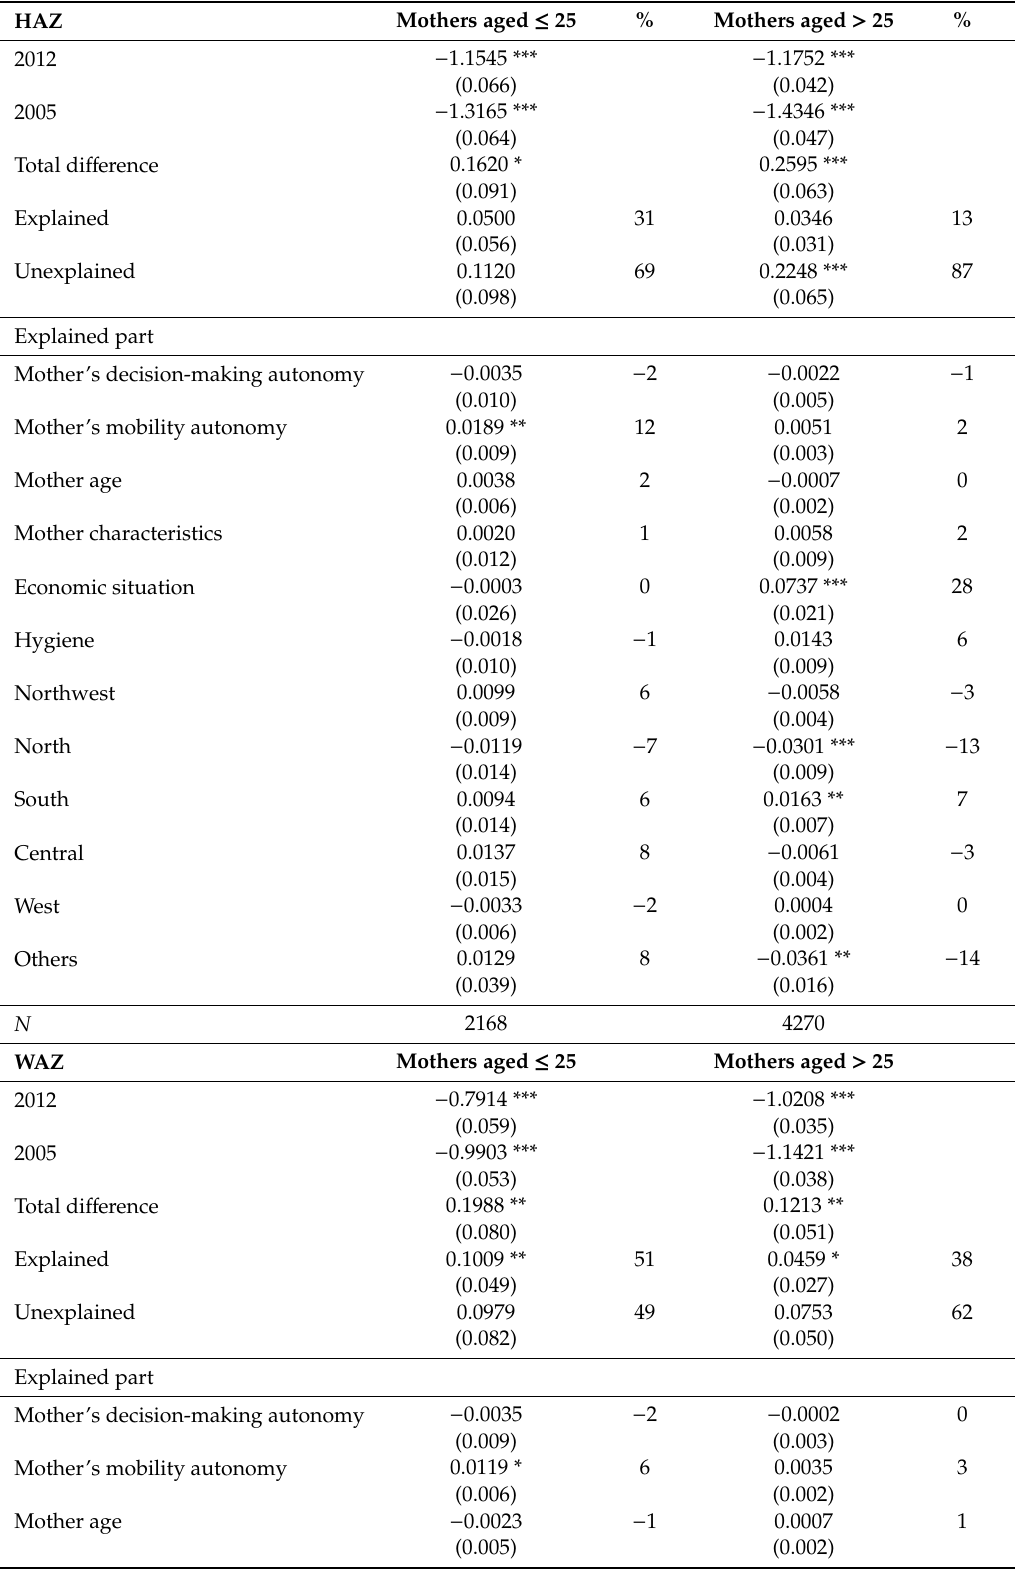
Table A3. Blinder-Oaxaca decomposition of socioeconomic di ff erences in malnutrition among Indian children under 5: IHDS 2004 / 2005–2011 / 2012(mothers aged ≤ 25 vs. mothers aged >